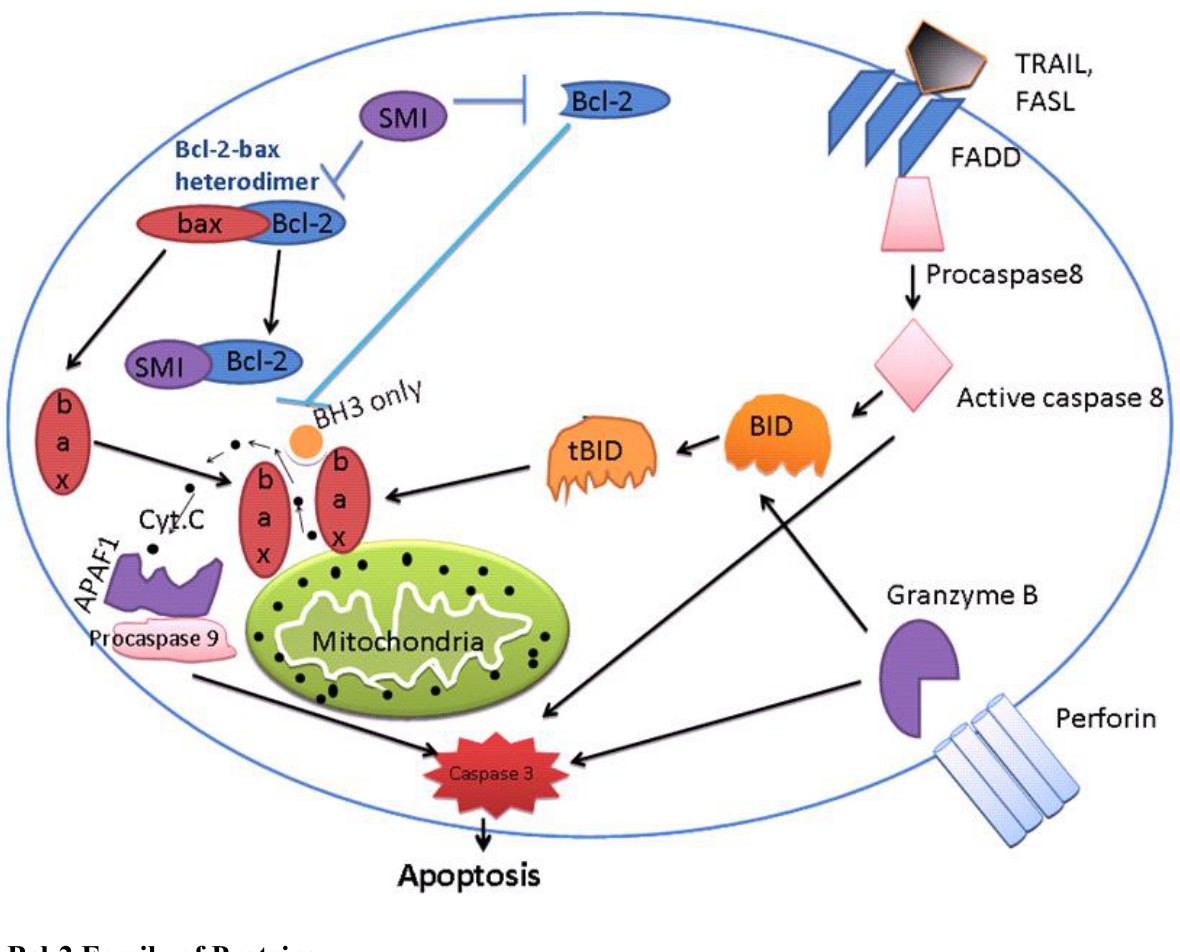
Figure 1. The Apoptotic Process. There are two major apoptotic signaling pathways: the extrinsic pathway and the mitochondria (intrinsic) pathway. In addition, there is another pathway that involves T-cell mediated cytotoxicity and perforin-granzyme-dependent killing of the cell. The mitochondrial (intrinsic) pathway is regulated by Bcl-2 family and activated by mitochondrial disruption with subsequent cytochrome c release. Initiators of this pathway include UV irradiation and cytotoxic drugs. An ‘apoptosome’ is formed by the interaction of cytochrome c, Apaf-1, d-ATP/ ATP and procaspase-9 with subsequent initiation of the caspase